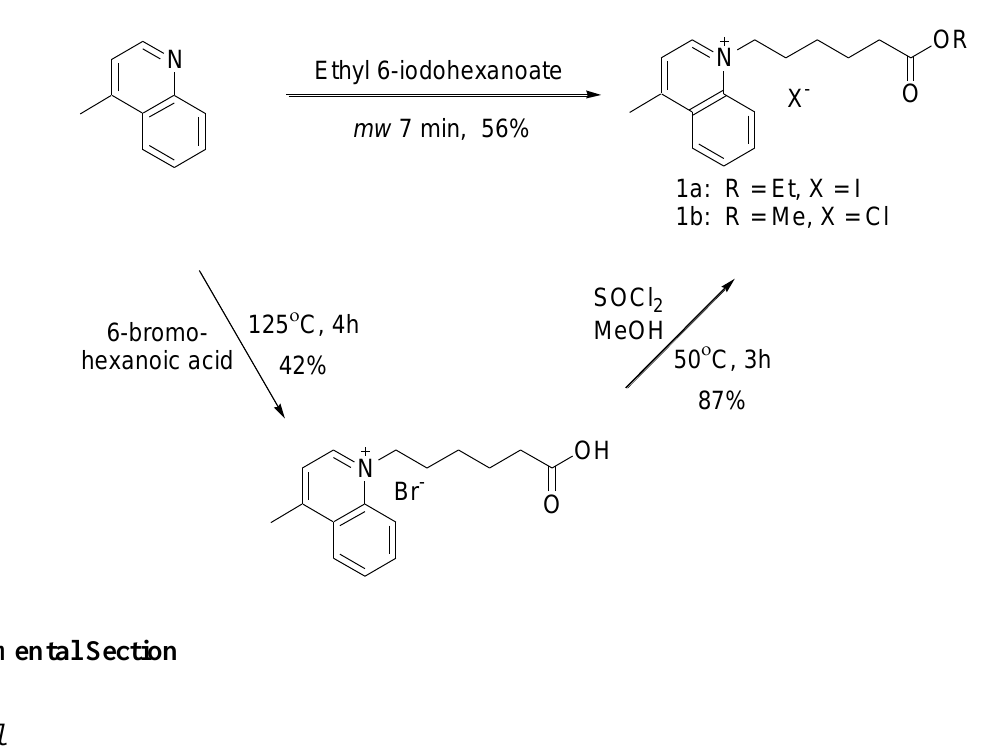
Scheme 1. Synthesis of quaternary